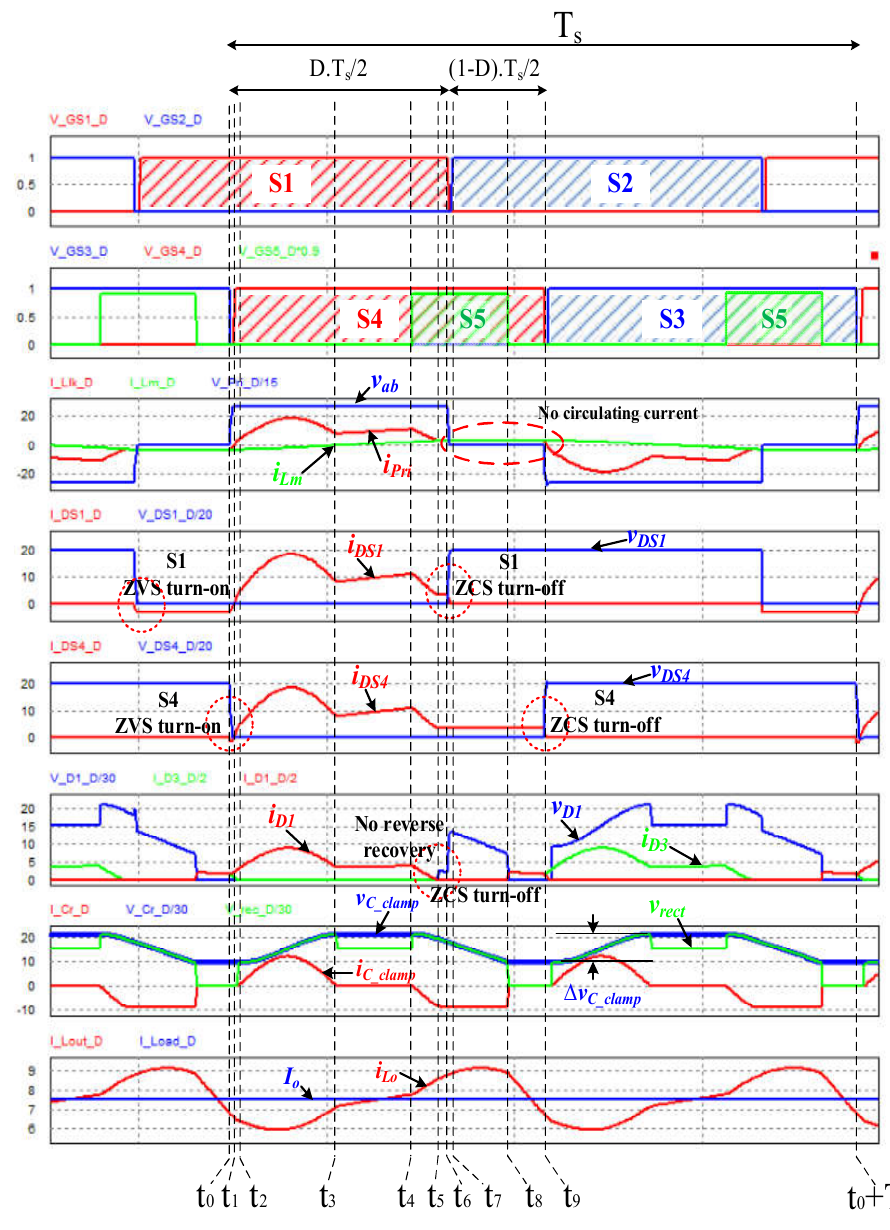
Figure 3. Key waveforms of the proposed converter.